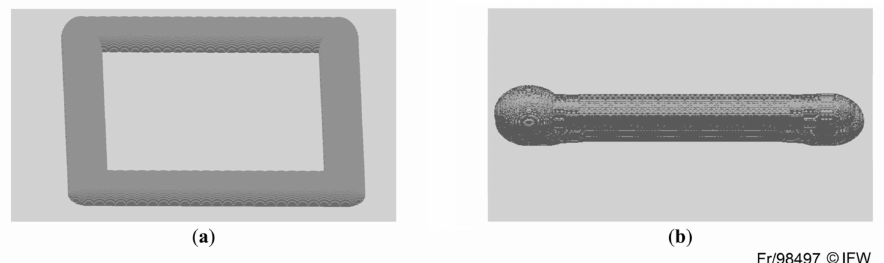
Figure 6. Simulation of two different weld seam geometries with the developed method in IFW CutS. ( a ) Simulation of direction change of the tool path with square weld seam; ( b ) two-layer weld seam with geometry variation (infeed and